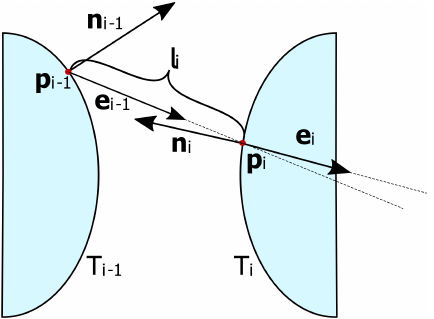
Figure 2. Schematics of a ray tracing step. Each topography T has its own coordinate system. The intersection point p i with topogra- phy T i is computed from the previous intersection point p i − 1 and the previous ray direction e i − 1 . Subsequently, the new ray direc- tion e i at T i is computed according to the laws of reflection and